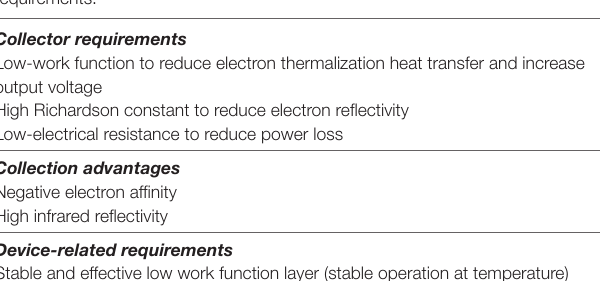
TABLe 2 | Collector requirements and advantages, and device-related